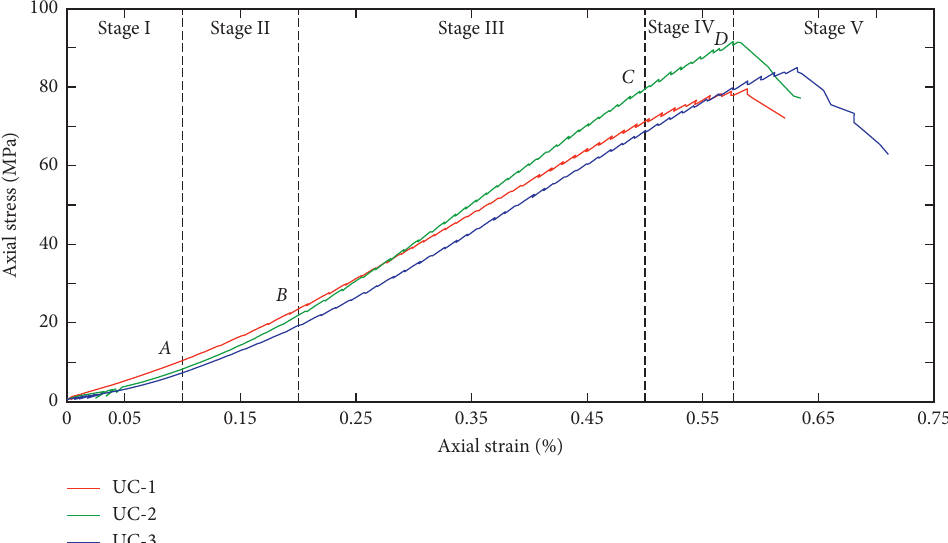
Figure 7: Axial stress-strain curve of sandstone under uniaxial